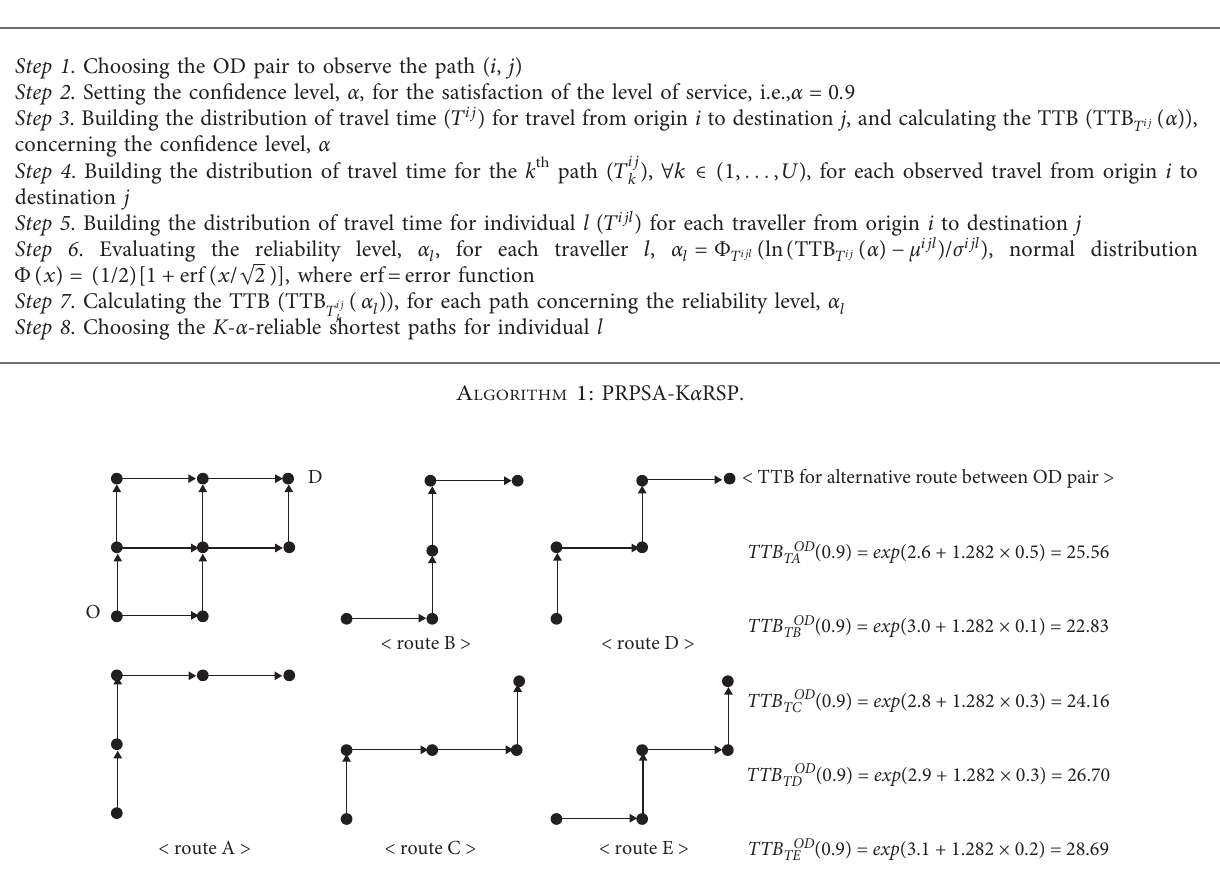
Figure 3: Route choice behaviour from perceived travel